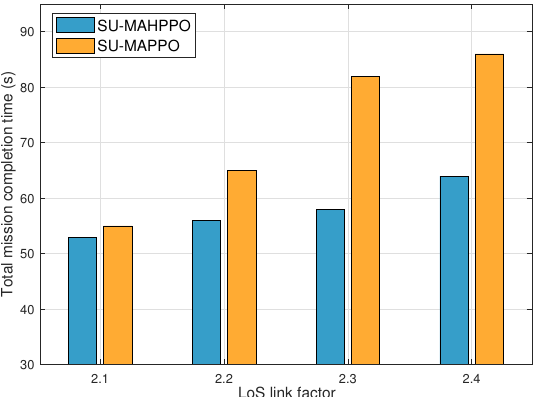
Figure 10. Total mission completion time with different LoS link